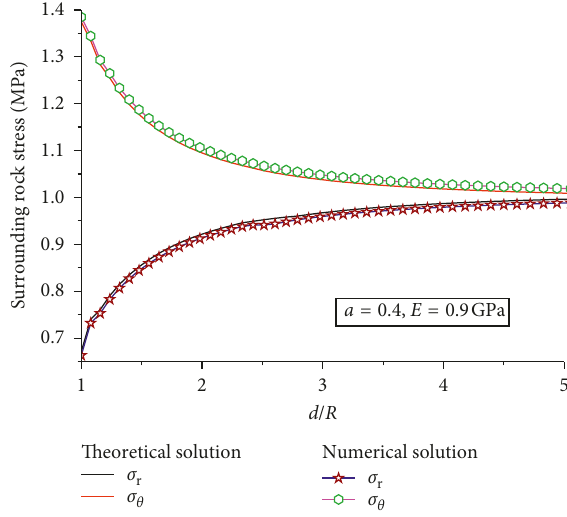
Figure 12: Comparison of surrounding rock stress when α